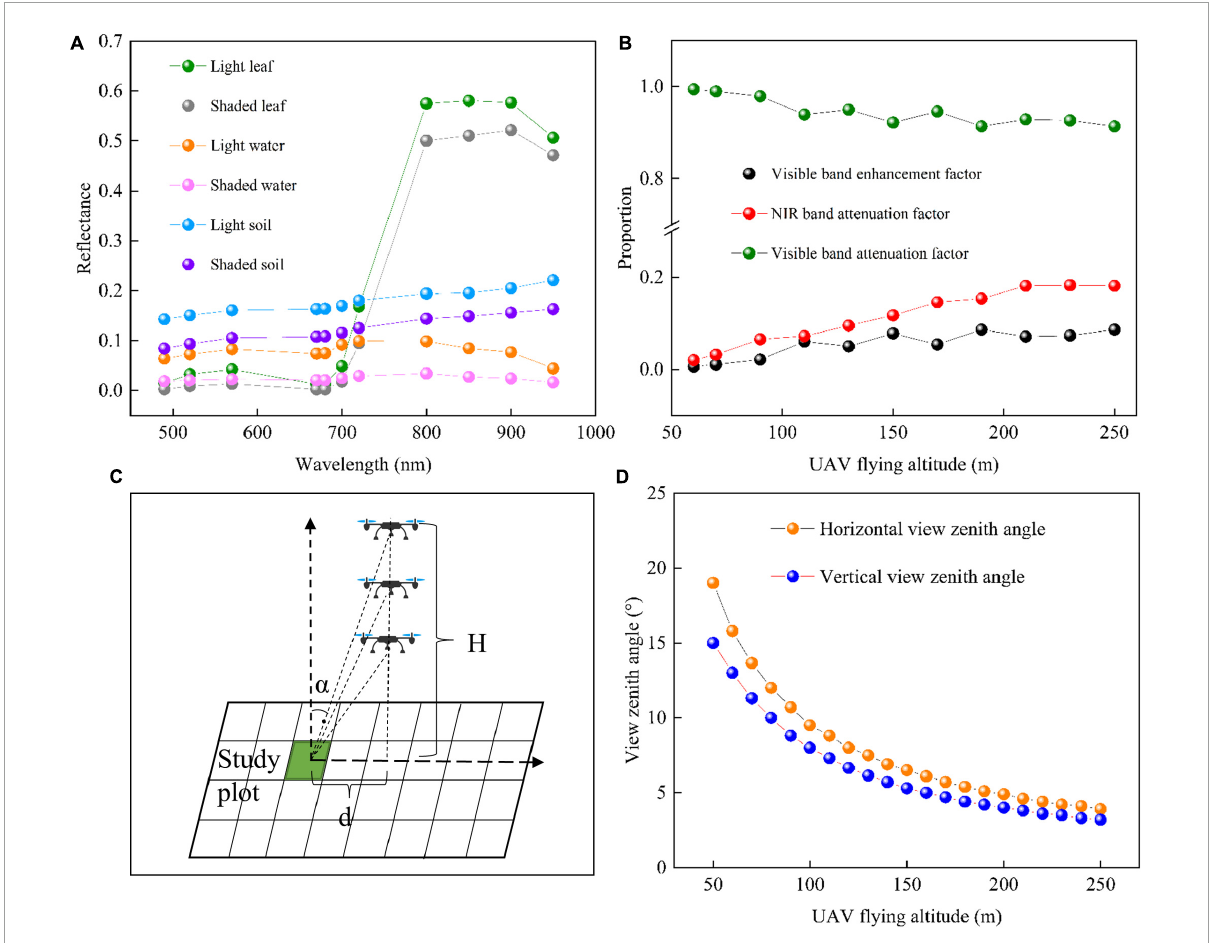
FIGURE4 The changes caused by different UAV-FAs: (A) Reflectance of different endmembers in the rice field; (B) mixed pixel decomposition results; (C) schematic diagram of UAV observation angle change at different altitudes, α is the VZA and H is the UAV flying altitude; and (D) the changes in edge-plot FOV with the increase of